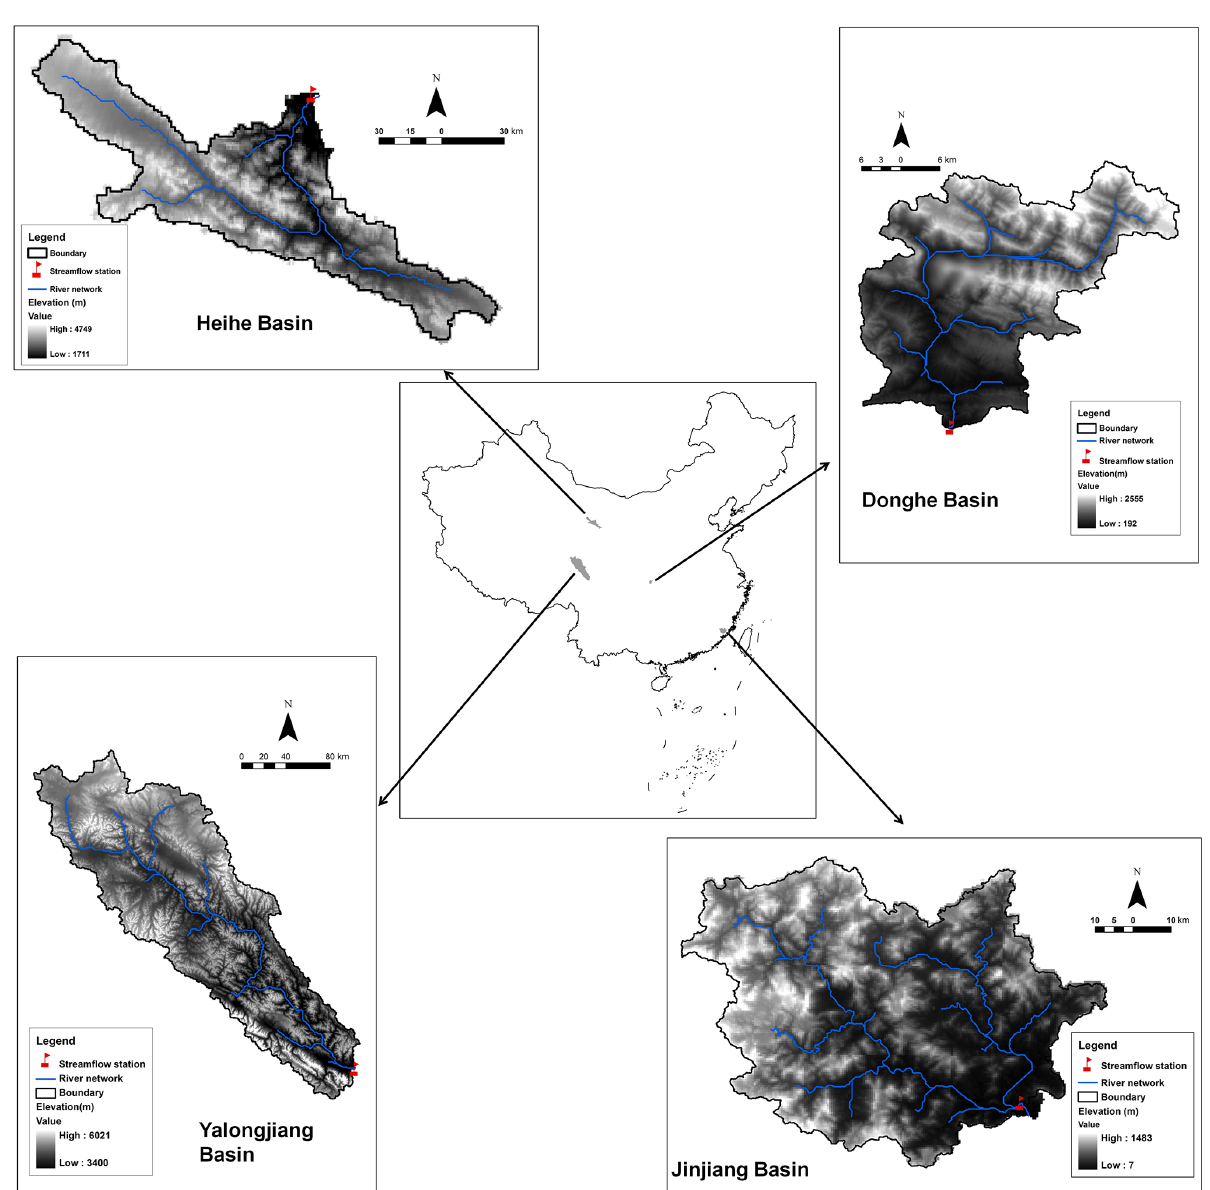
Figure 1. Topography, river networks, and the streamflow gauging stations of the four basins and their locations in